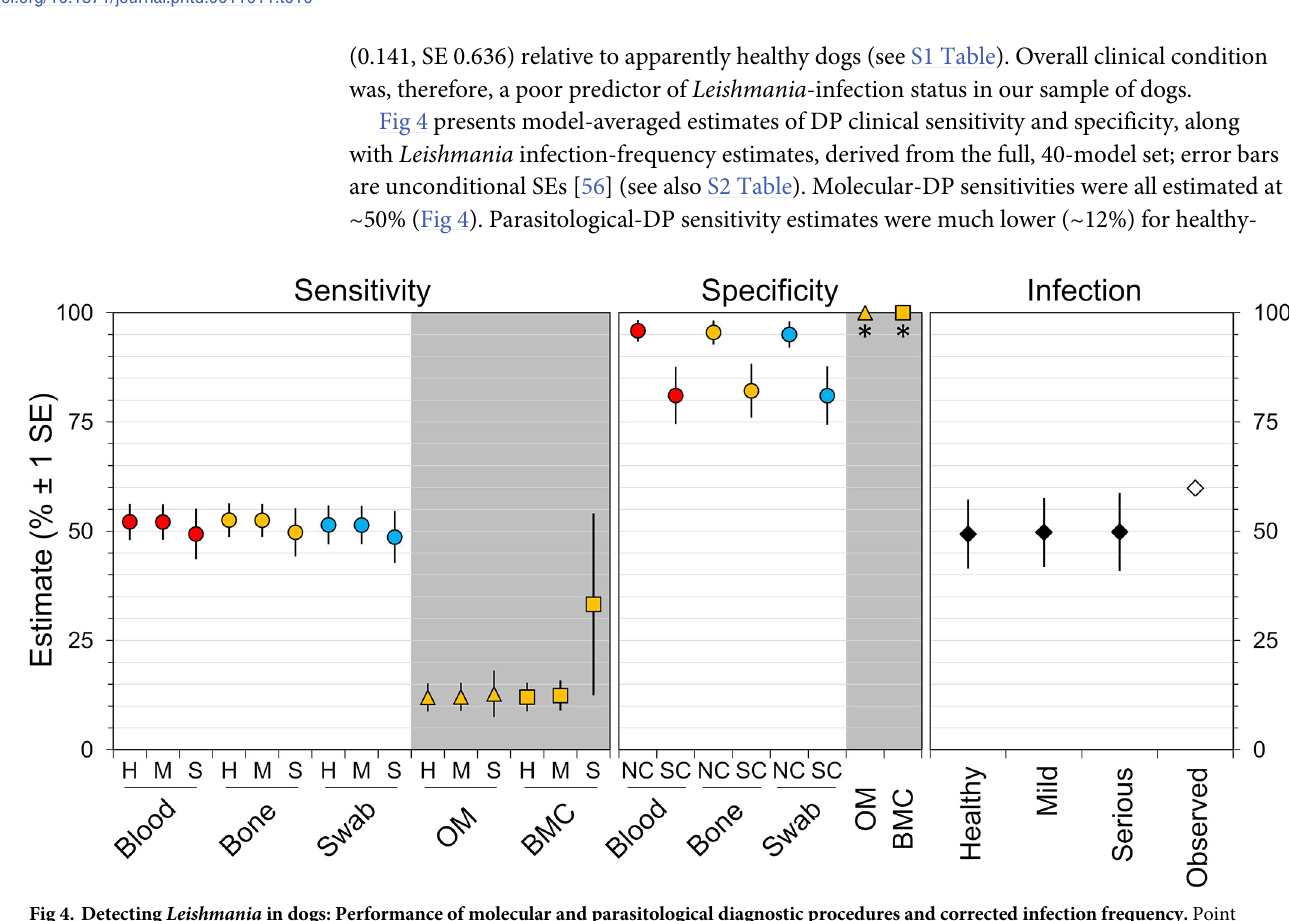
Fig 4. Detecting Leishmania in dogs: Performance of molecular and parasitological diagnostic procedures and corrected infection frequency. Point estimates are model-averaged values (expressed as percentages) derived from the full, 40-model set; error bars are unconditional standard errors ( ± 1 SE). All values correspond to a single procedure–one qPCR assay or one parasitological evaluation (in our case, two microscope-slide readings for optical microscopy and inverted optical microscope examination every two days over a 30-day period for parasite cultures). Circles represent molecular diagnostic procedures (quantitative PCR assays) run on different biological samples: peripheral blood (“Blood”, red), bone-marrow aspirates (“Bone”, orange), and eye swabs (“Swab”, blue). Parasitological diagnostic procedures (grey background) used bone-marrow aspirate samples (hence the orange color) and included optical microscopy (“OM”, triangles) and bone-marrow culture (“BMC”, squares); note that specificity values were fixed at 100% for OM and BMC (see asterisks). Diamonds represent infection-frequency estimates (black) and observed infection frequency (white; calculated as the percent of dogs with at least one positive result in any diagnostic procedure). Dogs in our sample were apparently healthy (“H” or “Healthy”), mildly diseased (“M” or “Mild”), or seriously diseased (“S” or “Serious”). The specificity of molecular diagnostic procedures was estimated for qPCR assays run on plates with no evidence of contamination (“NC”) or on plates with suspected contamination